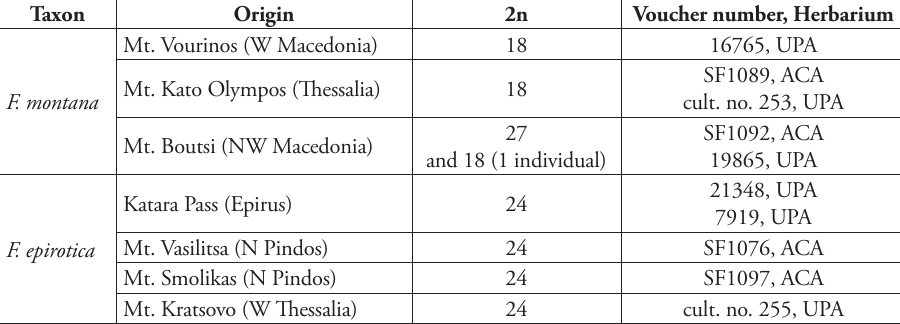
Table 1. Origin, chromosome numbers (2n) and voucher number of Fritillaria material. Taxon Origin